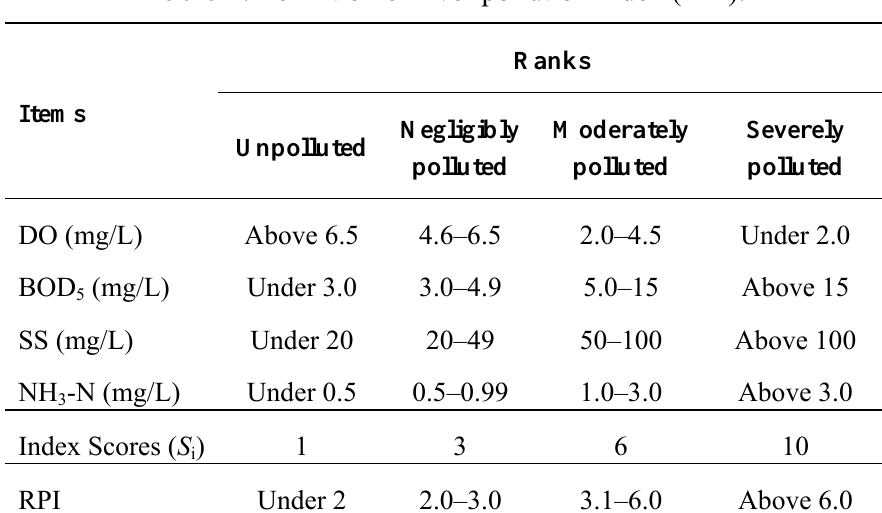
Table 1. Definition of river pollution index